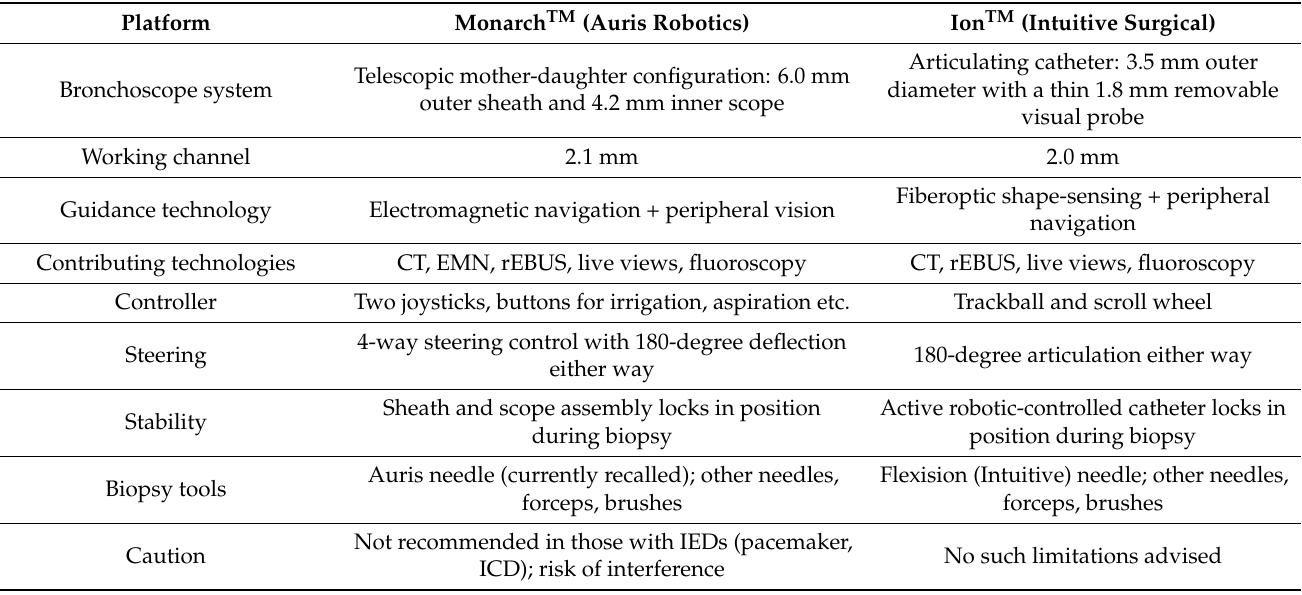
Table 1. Comparison of the technical aspects of the two